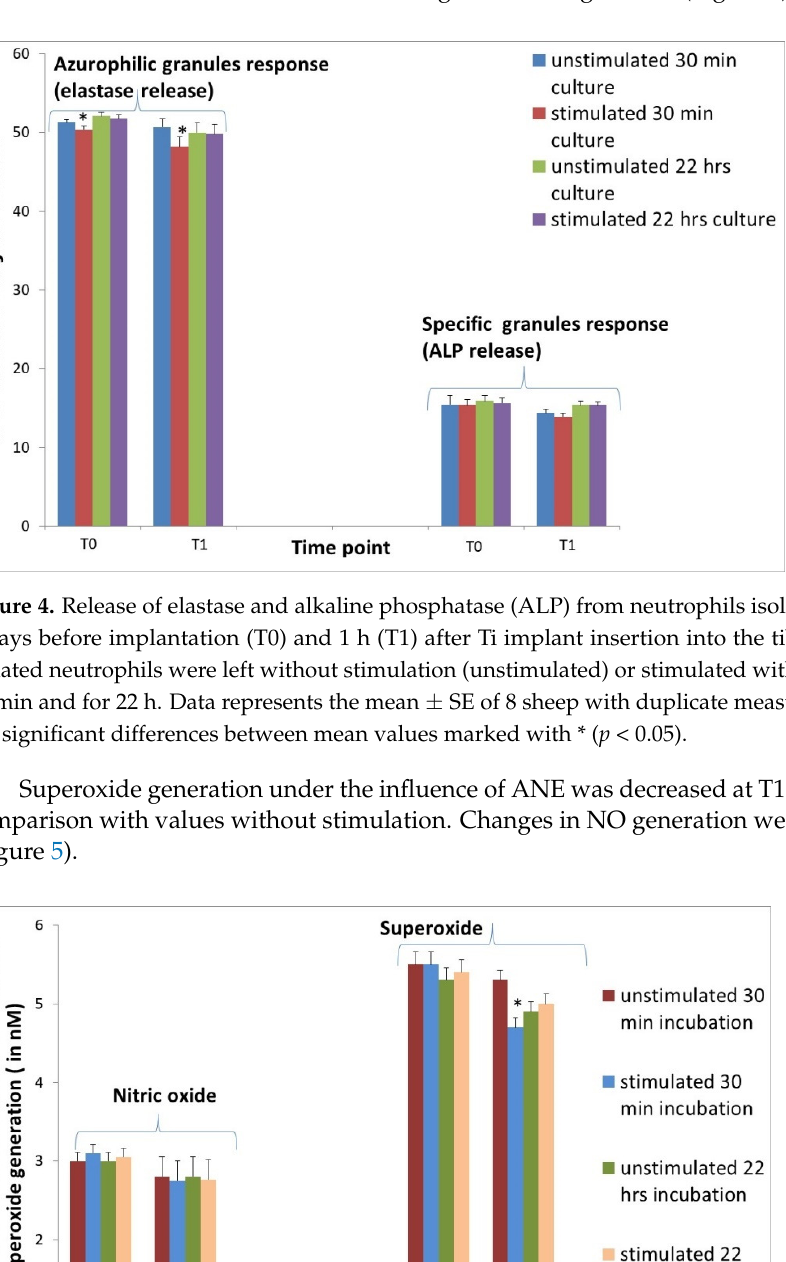
8 of 18 Figure 3. Test of potential cytotoxic and hemolytic ANE activity against host cells (neutrophils and erythrocytes, respectively). ANE was used at concentrations of 4, 40, and 100 μ g/mL. Dose-dependent reduction in viability and increased hemolysis were observed (* p < 0.05 compared to 0 μ g/mL).